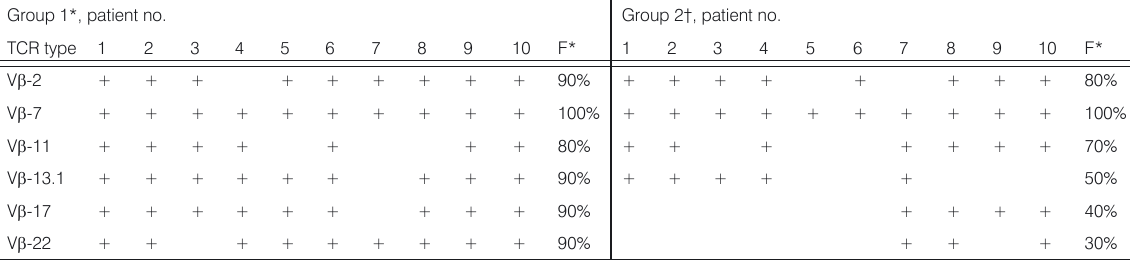
Table 4. Western blot analysis of TCR V β expression in patients with psoriasis from the two groups